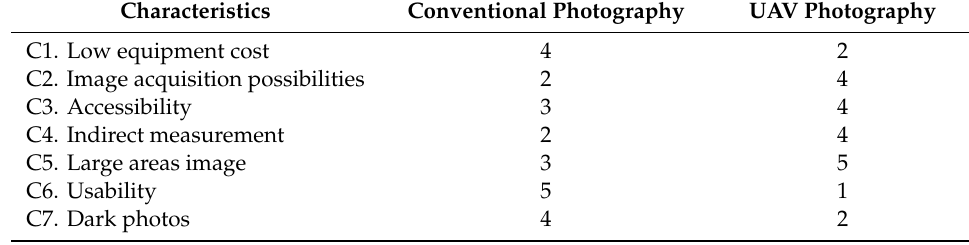
Table 4. Characteristic values for conventional and UAV photography.